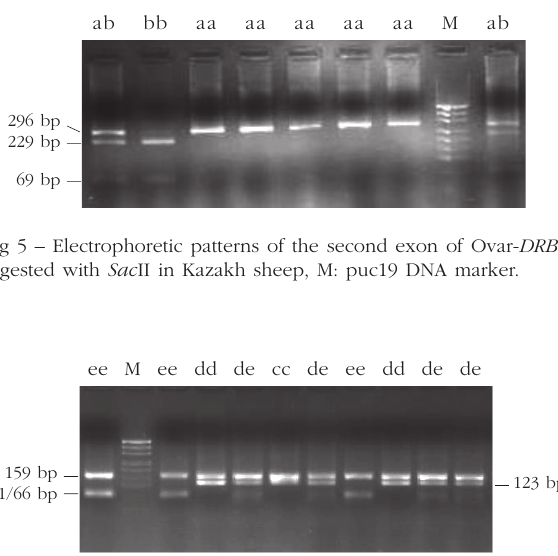
Fig 3 – Electrophoretic patterns of the second exon of Ovar- DRB 1 digested with Hin 1I in Kazakh sheep, M: puc19 DNA marker.